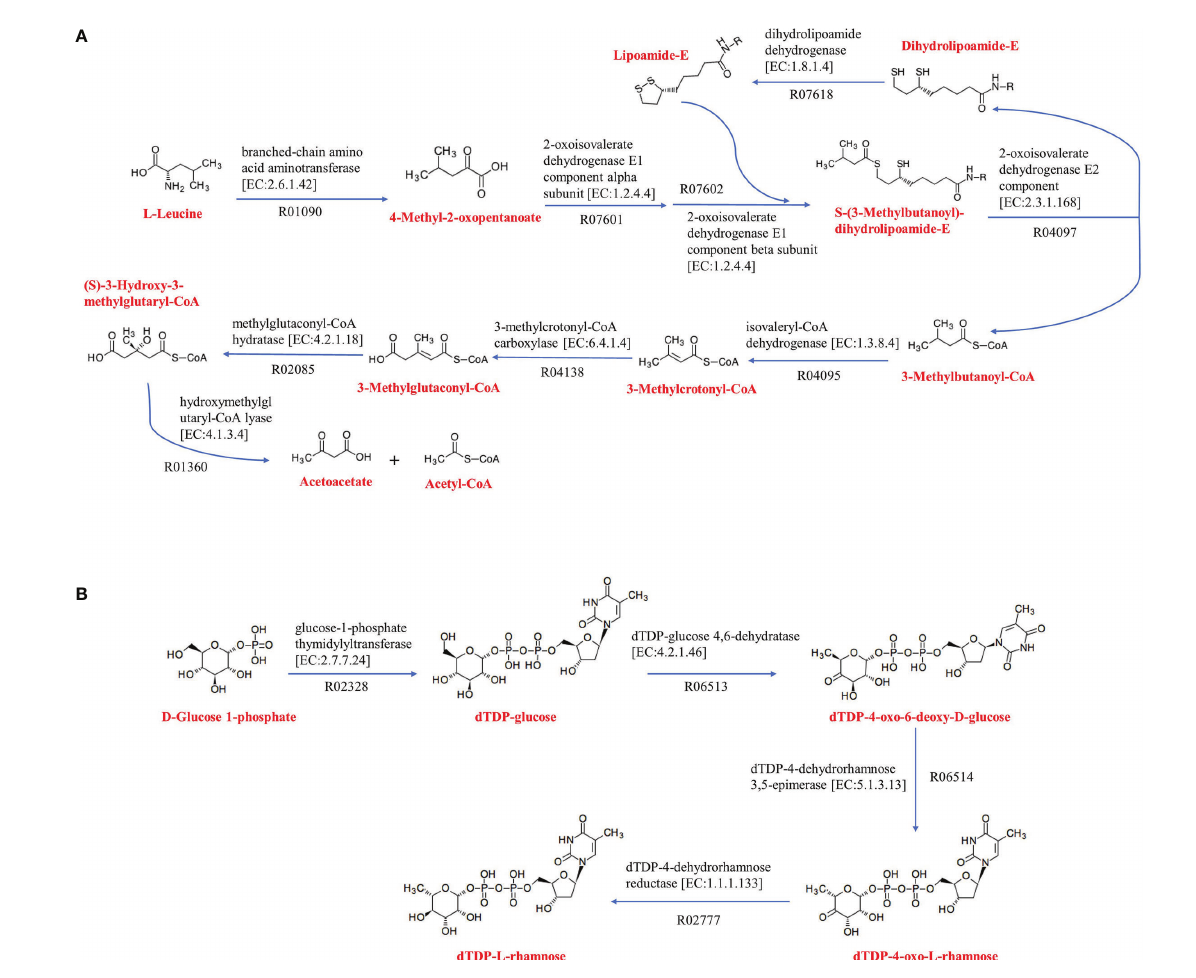
FIGURE 5 | Amino acid metabolism and polyketide sugar unit biosynthesis of Kordiimonas strains. (A) Leucine degradation. (B) dTDP-L-rhamnose biosynthesis. The metabolic pathway maps are based on the KEGG analysis. Other reactants and products have been